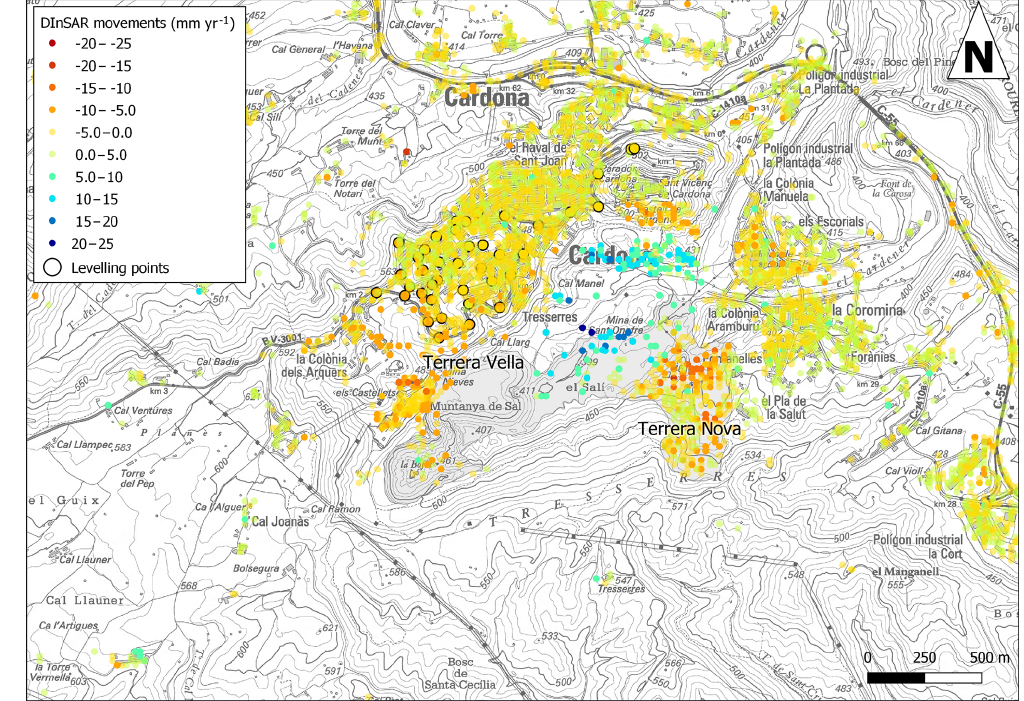
Figure 4. Levelling based and DInSAR based terrain movement velocities determined from movement measures gathered in its respective